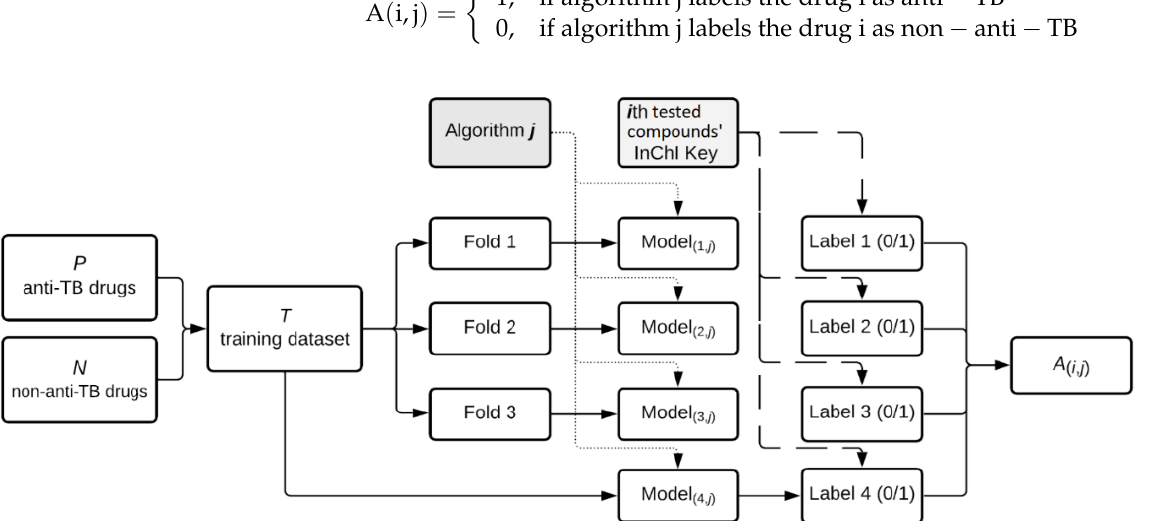
Figure 4. Overview of the machine learning approach: we split the training dataset T (consisting of the reunion of P and N sets) into three subsets, namely Fold 1, Fold 2, and Fold 3. After training a model with an algorithm j with one of the 3 subsets or the entire training set, we obtain a label that we use to compute, for each tested compound i, the final score/label of an algorithm j, the value presented in Table 1 on line i, column j, A(i,j).